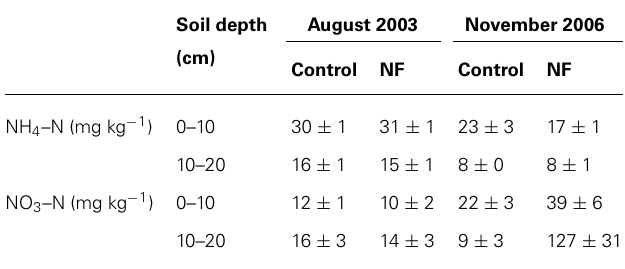
Table 1 | Concentration of inorganic nitrogen in the soil before and after N fertilization.